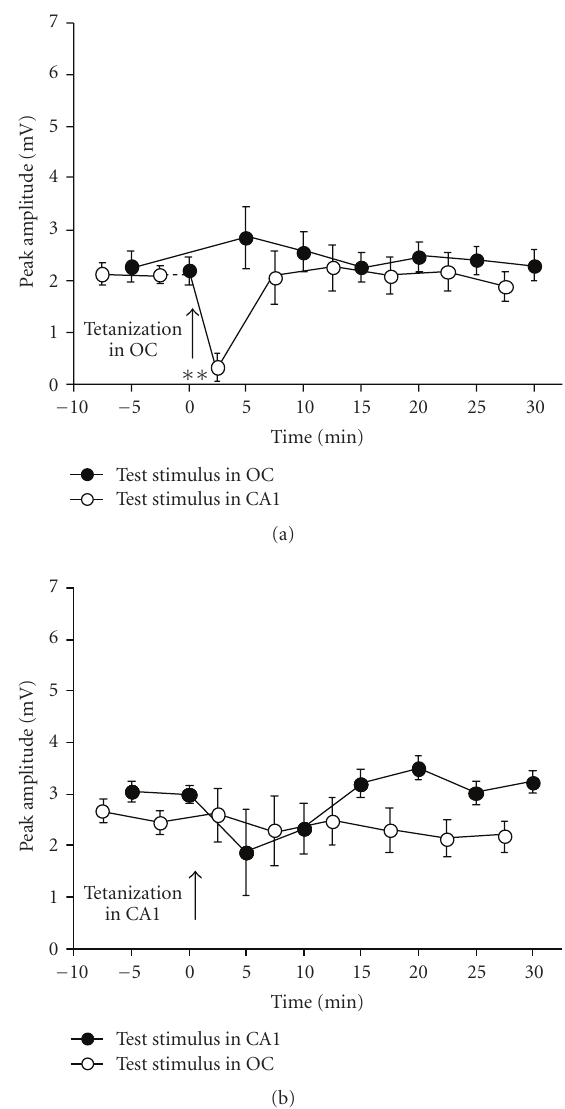
Figure 3: Failure of tetanizing stimulation applied to the occipital cortex (a) or to the ventral CA1 hippocampal region (b) to induce LTP in the medial entorhinal cortex of 55–60-day-old prenatally malnourished rats. The arrow indicates time of application of the tetanizing stimulus. N = 8 rats in all groups. Values are means ± SEM of peak-to-peak amplitudes, 30 responses averaged per rat. It can be noted that neither homosynaptic nor heterosynaptic potentiation occurred in the EC of malnourished animals. One-way ANOVA followed by Dunnett’s multiple comparisons test indicated no significant intragroup di ff erences in peak-to-peak amplitudes when comparing posttetanizing values with the last pretetanizing basal point (at 0 minute), excepting for block 2.5–5 minutes (a) where significant inhibition ( ∗∗ P < . 01)